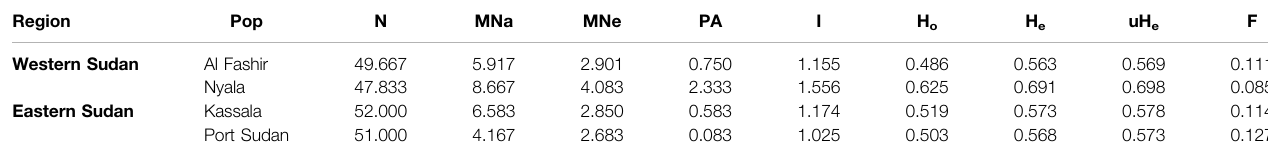
TABLE 1 | Summary of the mean genetic diversity indices over loci for each of Aedes aegypti mosquito populations. Region Pop